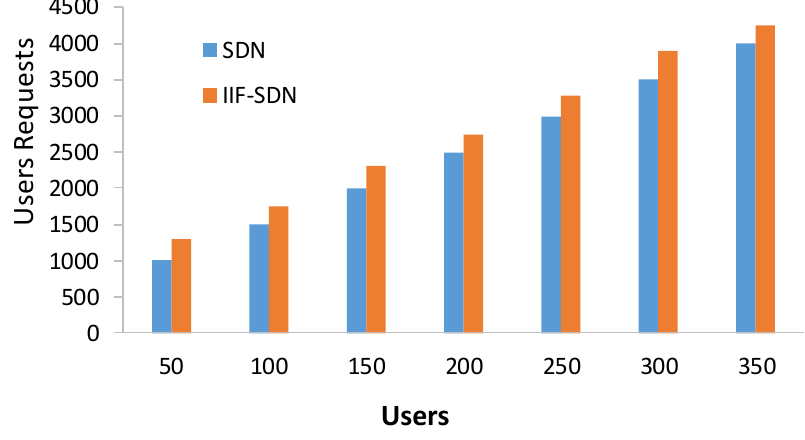
Figure 18. Overall performance.